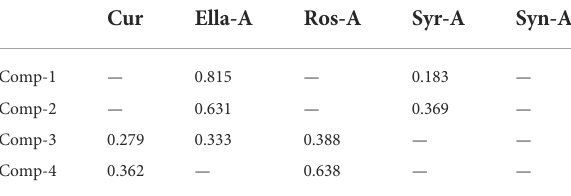
TABLE 2 Compounds ratio of optimal